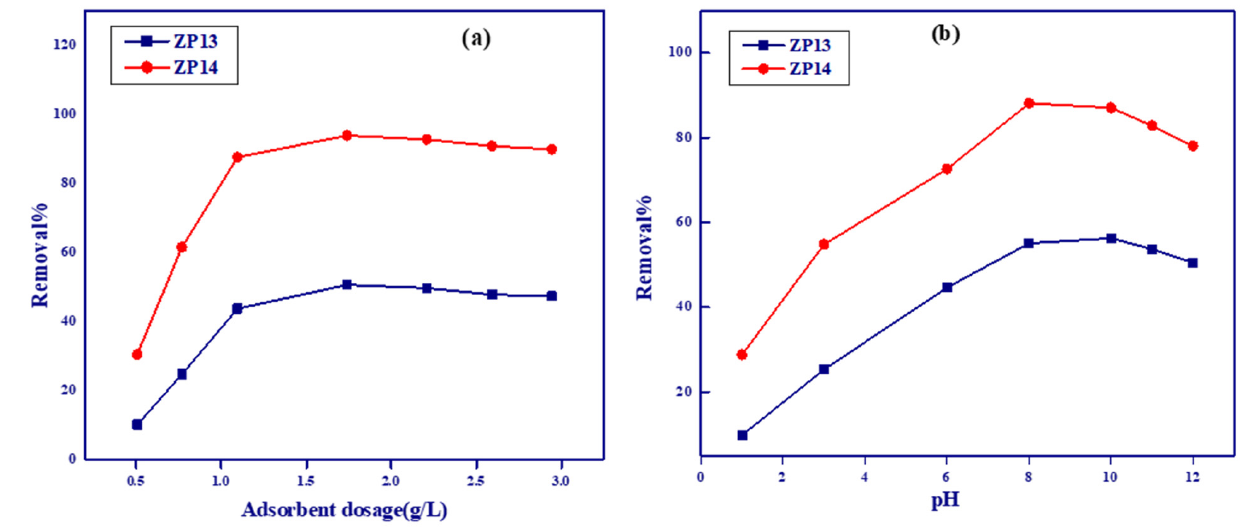
Figure 5. Effect of adsorbent dosage ( a ) and effect of pH ( b ) on adsorption of methylene blue onto ZP13 and ZP14.